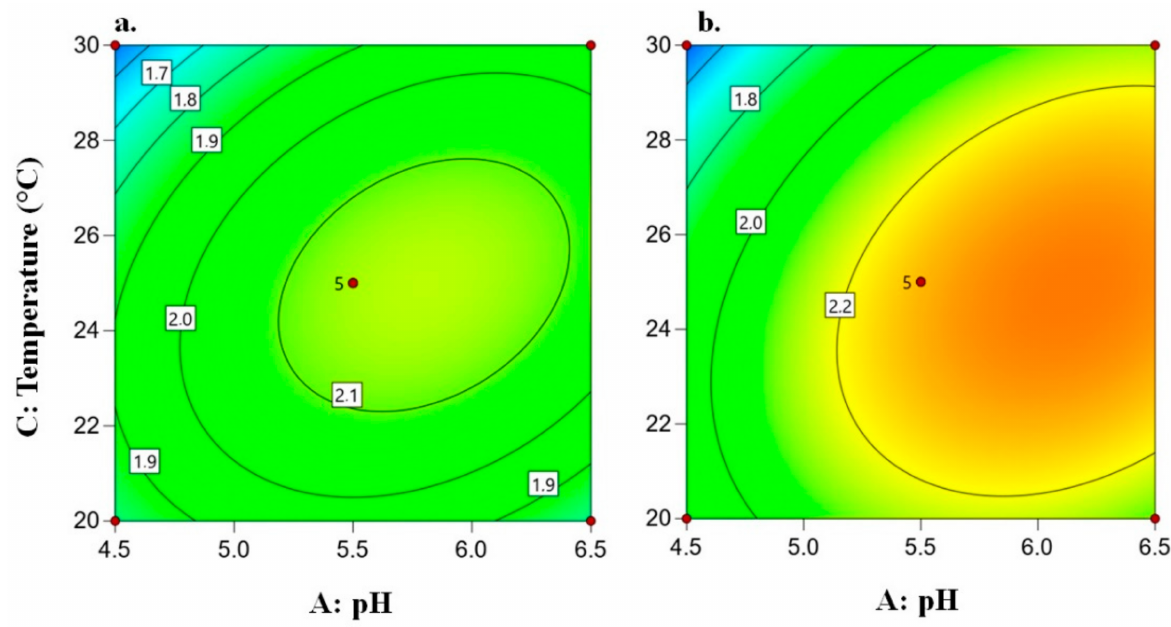
Figure 3. Effect of temperature and pH on the yeast cell viability during fermentation after the pretreatment of sugarcane press-mud under ( a ) acid hydrolysis and ( b ) hydrothermal conditions. Fermentation conditions: stirring, 100 rpm; time, 24